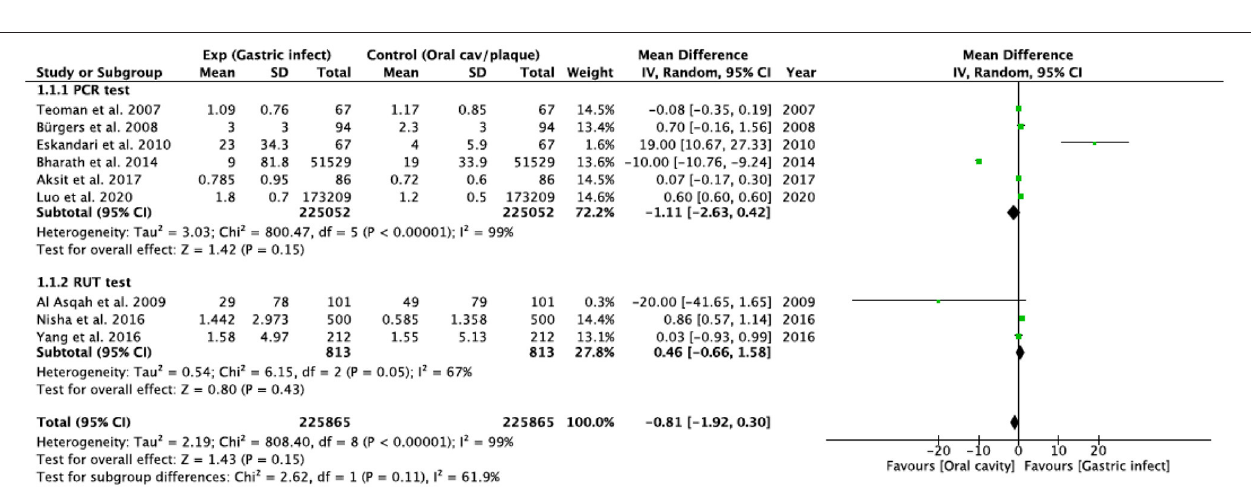
FIGURE 3 | Subgroup